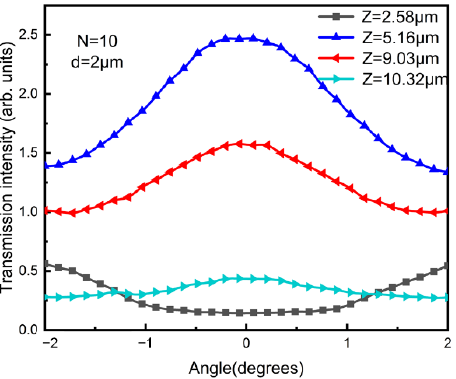
Figure 5. Simulated transmission intensity with different distances between the two gratings in which Z = 2.58 μ m, 5.16 μ m, 9.03 μ m and 10.32 μ m, respectively.